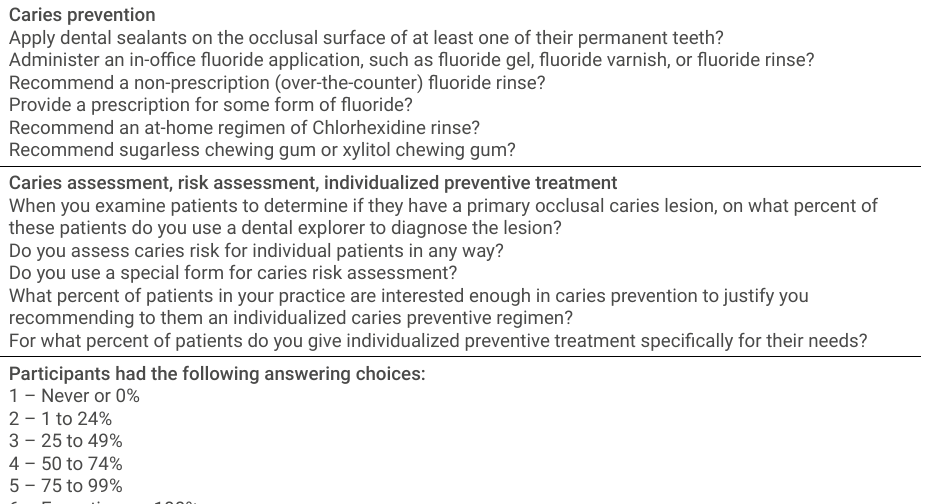
Table 1. Questions asked about caries prevention, assessment, caries risk assessment, and individualized preventive treatment. Instructions: Of patients more than 18 years old, for what percentage do you: